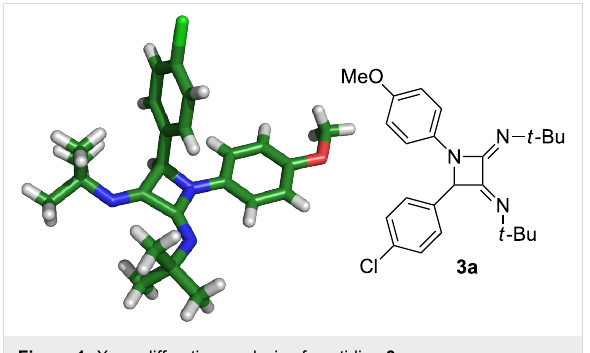
Figure 1: X-ray diffraction analysis of azetidine 3a